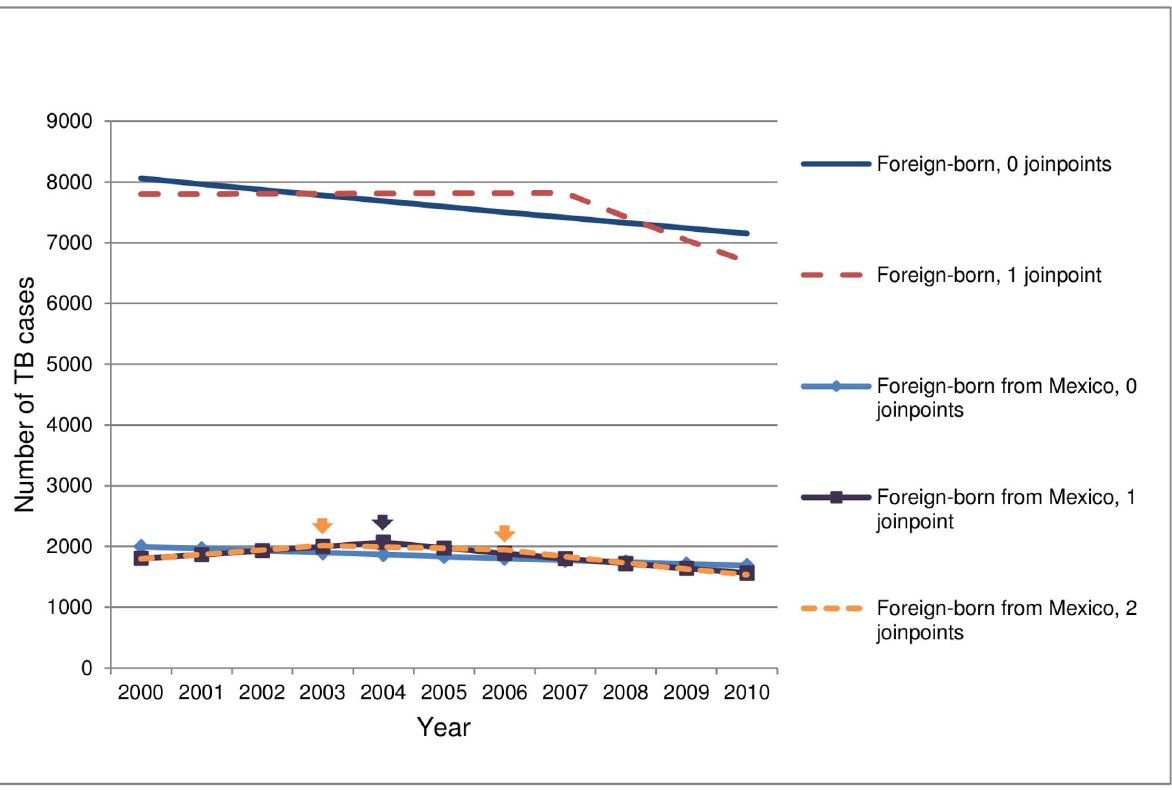
Figure 2. Number of tuberculosis (TB) cases modeled with 0 and 1 significant changes in trend for all foreign-born persons and 0, 1, and 2 significant changes in trend for foreign-born persons from Mexico, 2000–2010. Significant changes in trend were determined using Joinpoint analysis (Joinpoint version 3.5.2, Bethesda, MD http://surveillance.cancer.gov/joinpoint/). Arrows indicate the years in which significant changes in trend for foreign-born persons from Mexico occurred (blue arrow corresponds to model results with a single change in trend and red arrows correspond to model results with 2 changes in trend).